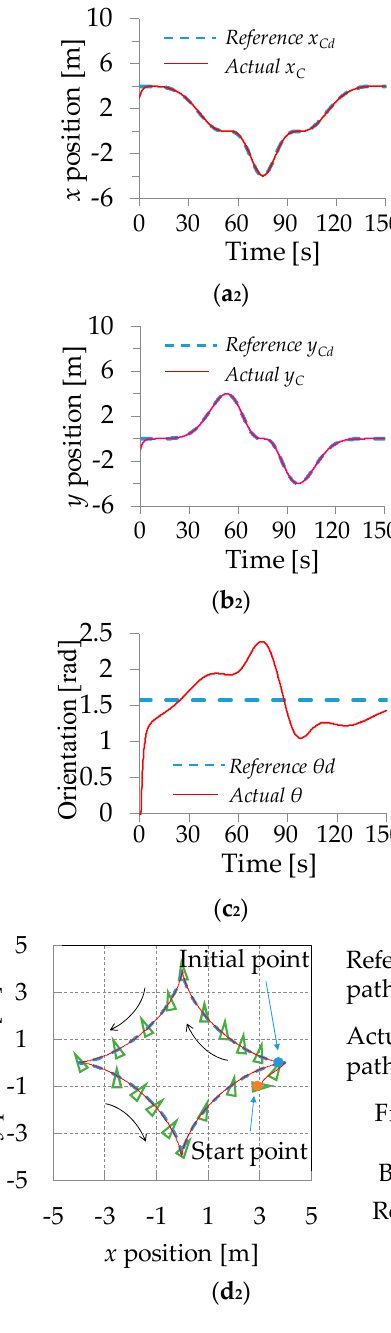
Figure 9. Trajectory and path tracking performance of the robust feedback tracking controller for the astroid path (primitive parameters m = 6 kg, r 0 = 0.2 m, α = π /2, R a = 0.56 Ω , and F friction = 0 : ( a 1 ) x position; ( b 1 ) y position; ( c 1 ) orientation θ ; and ( d 1 ) path tracking) (changed parameters m = 26 kg, r 0 = 0.3 m, α = π /3, R a = 0.76 Ω , and F friction = [0.2 N, 0.2 N, 0,3 N ∙ m]: ( a 2 ) x position; ( b 2 ) y position; ( c 2 ) orientation θ ; and ( d 2 ) path tracking).